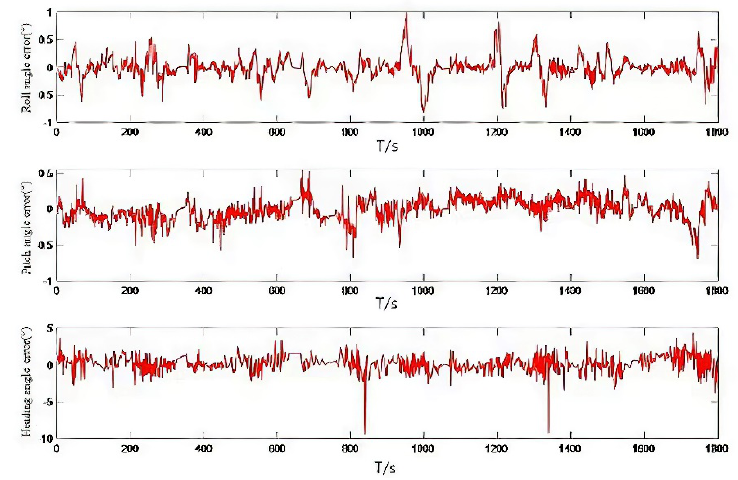
Figure 9. Attitude angle error .